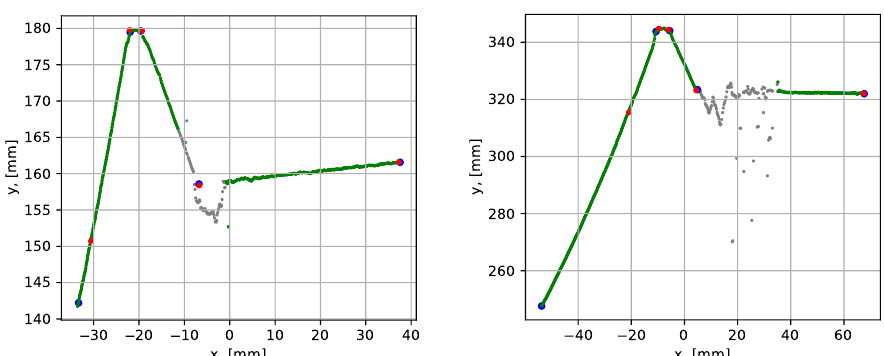
Figure 23. Parametrization results with groove corner points for datasets 8 (to the left) and 9 (to the right). The blue dots show the result before the iterative error elimination procedure and the red dots show after. The grey points have been identified as noise by the noise detection algorithm.